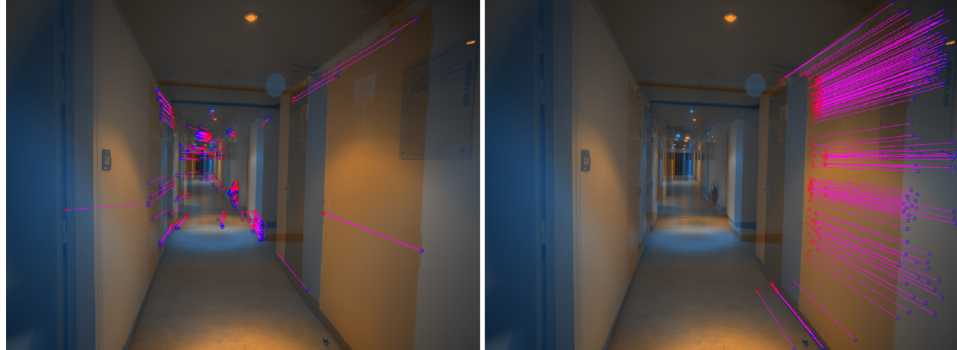
Figure 24. An explanation for the reduction of tie-points multiplicity by SIROP in Hallway dataset. These are tie-points in one image couple in the dataset. ( Left ): SIFT detects tie-point at the far end of the scene, so these tie-points have a high multiplicity because it appears on almost all image couples. ( Right ): our method extracts tie-points in the optimal resolution of scene, so all the “far” scene part is eliminated.